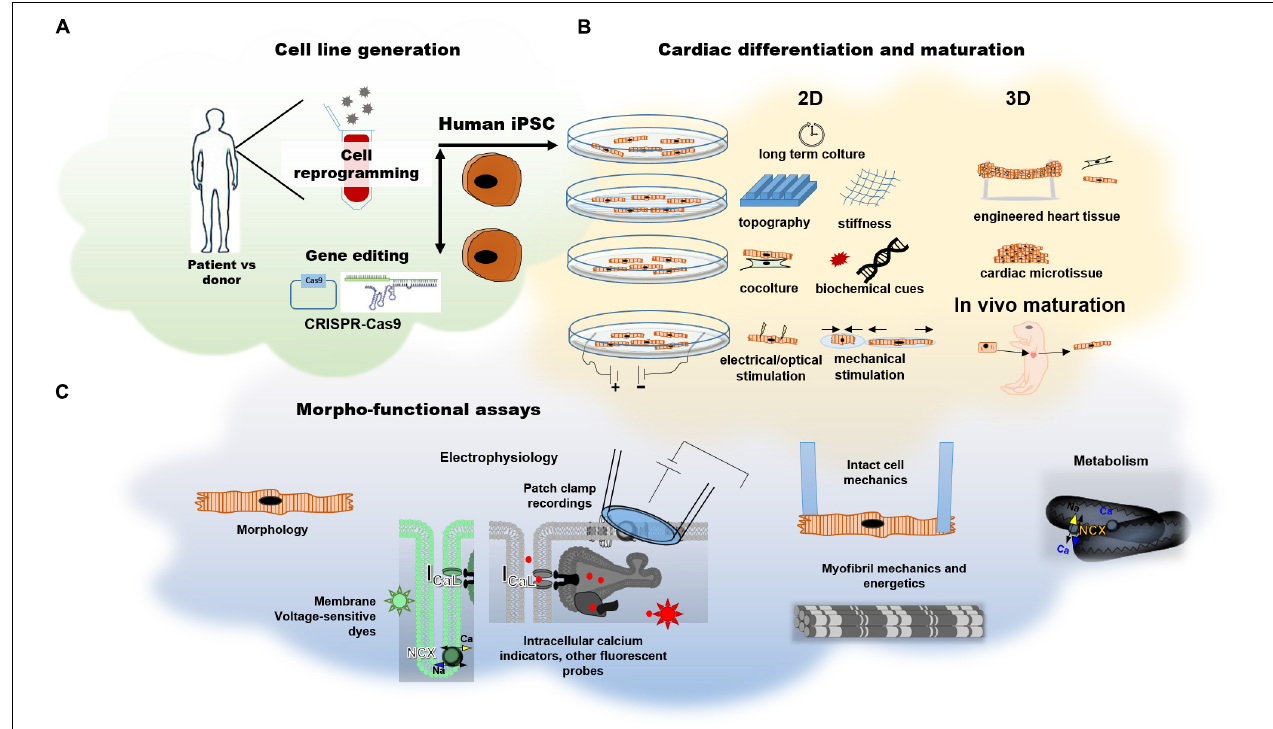
FIGURE 3 | Human induced pluripotent stem cell derived cardiomyocytes. (A) Generation of hiPSCs by cell reprogramming of somatic cells from patients or healthy donors or via CRISPR-Cas9 gene editing for the generation of isogenic pairs. (B) Current maturation strategies for hiPSC-CMs at cell level (2D strategies) or in multicellular model (3D strategies). (C) Possible methods for the assessment of electrophysiological and contractile properties.